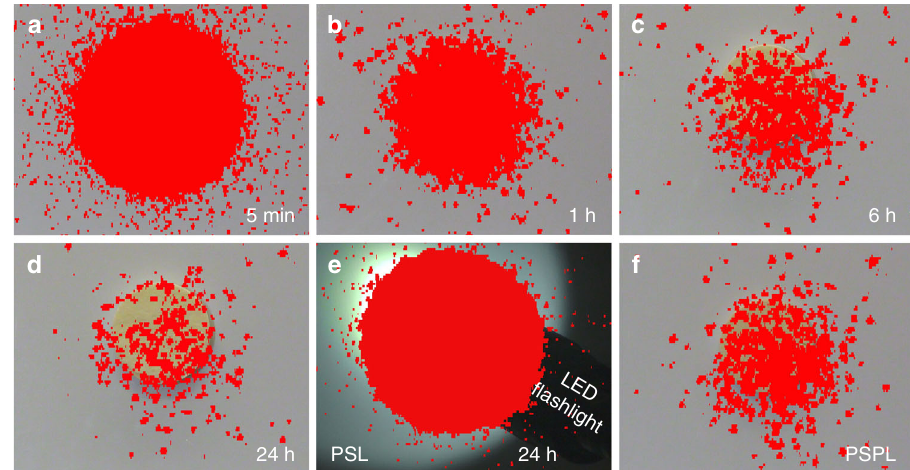
Fig. 3 Ultraviolet-C images of a decaying Ca 2 Al 2 SiO 7 :Pr 3 + disc in room sunlight. a – d Ultraviolet-C (UVC) images of a 50 mm diameter disc taken at different decay time (5 min to 24 h) using a corona camera. The disc was pre-irradiated by a 254 nm lamp for 2 min. e UVC photostimulated luminescence (PSL) image of the 24 h decayed disc being irradiated by a 3800 Lumen white LED fl ashlight. The irradiation lasted for 10 s. f UVC photostimulated persistent luminescence (PSPL) image taken at 1 min after ceasing the fl ashlight irradiation. The UVC radiation is represented by red color. The camera was located about 5 m away from the